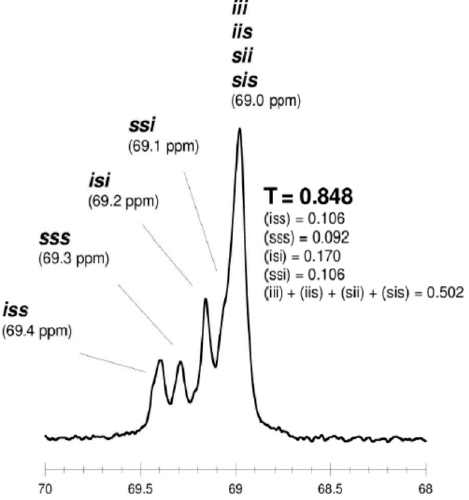
Figure 4. Homonuclear decoupled 1 H-NMR spectra of the methine region of polylactide ( PLA 14 ). Molecules 2015 , 20 , page–page